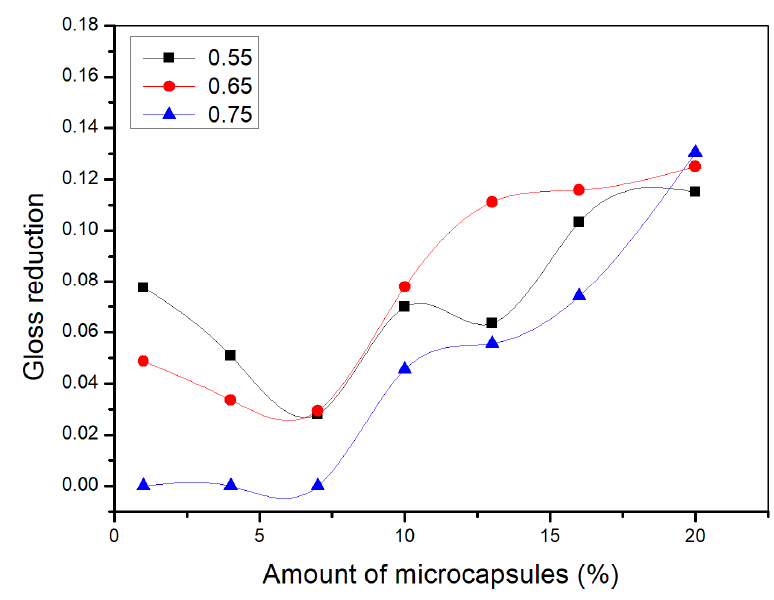
Figure 9. Gloss reduction in the coating after drying at 120 °C for 2 h.